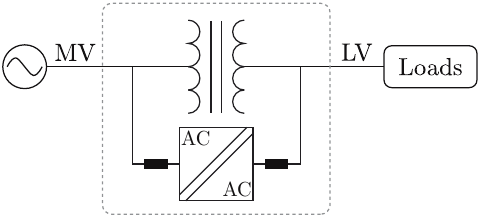
Figure 21. Increase in an LFT capacity by means of a HDT.